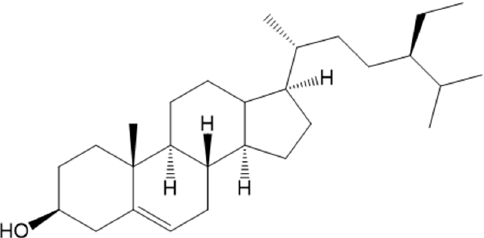
Figure 3. Skeletal structure of β -sitosterol—an example of a phytosterol.